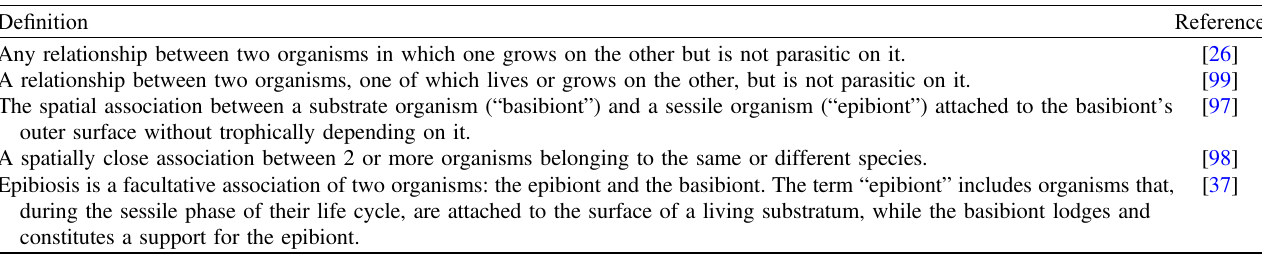
Table 6. Various de fi nitions of epibiosis in the literature.